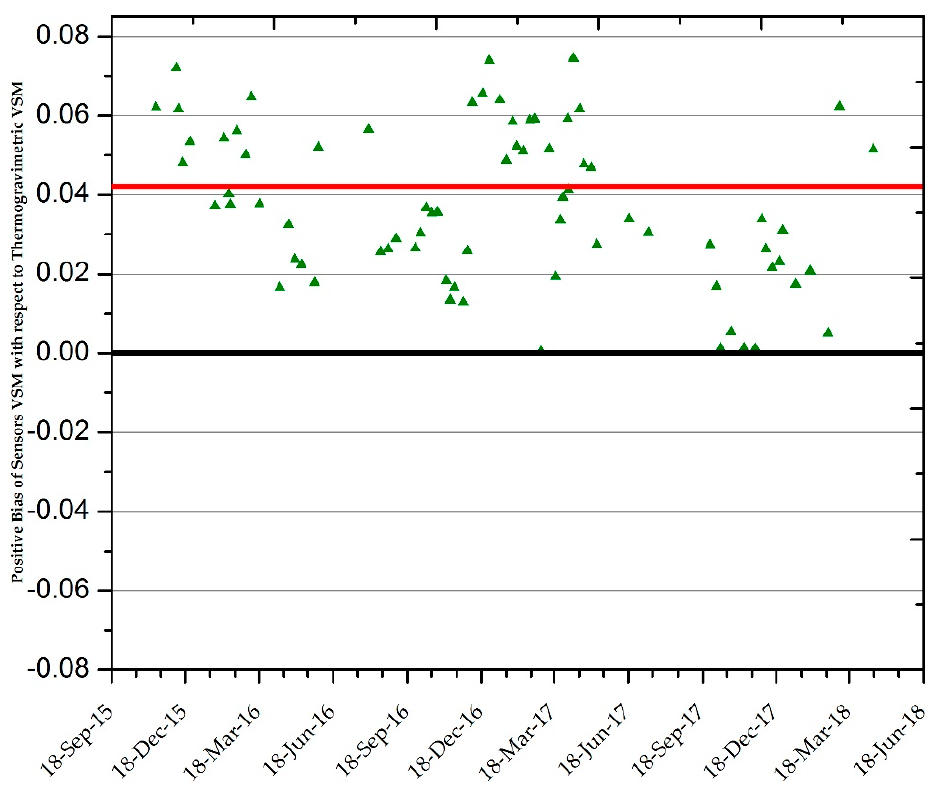
Figure 4. Positive bias of sensor observations with respect to thermogravimetric VSM from Kuwait test sites (RMSE value 0.042 m 3 m − 3 indicated by a red line) .